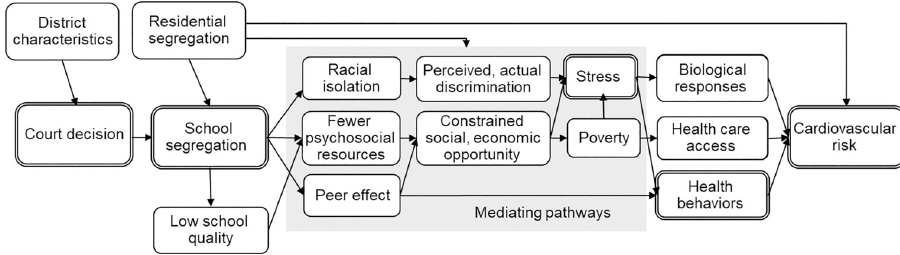
Fig 1. Conceptual model illustrating the pathways linking school racial segregation with cardiovascular risk. Boxes with double borders represent the exposure, instrument, and outcomes of interest.